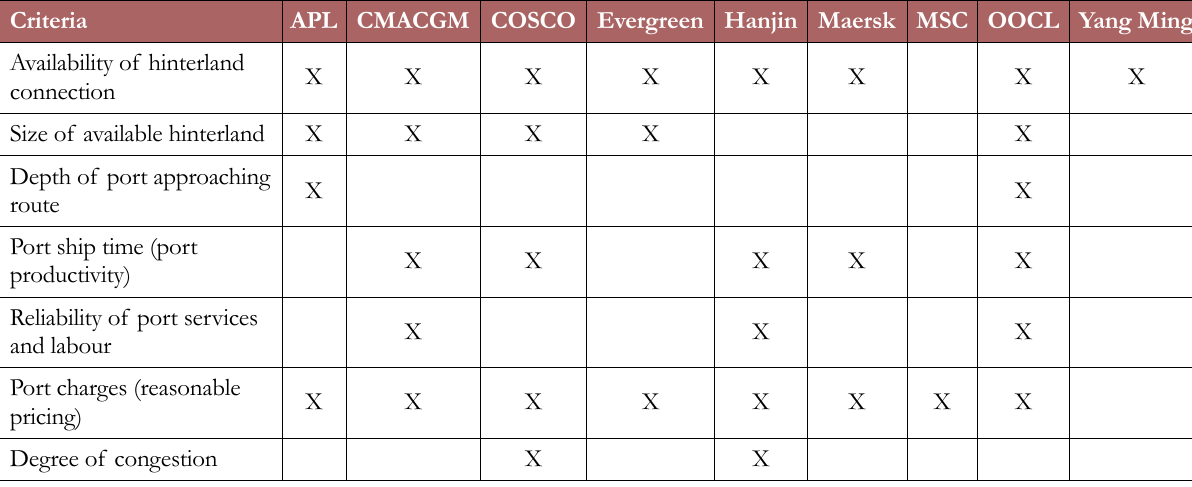
Table 1. Overview of Criteria’s for Choice by Shipping Lines (Wiegmans et al., 2008: page